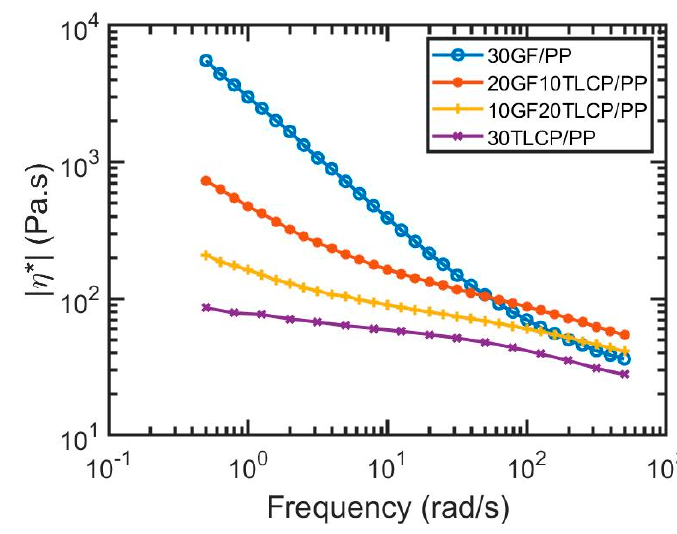
Figure 6. SAOS frequency sweep of hybrid composites at 305 °C in a nitrogen atmosphere.